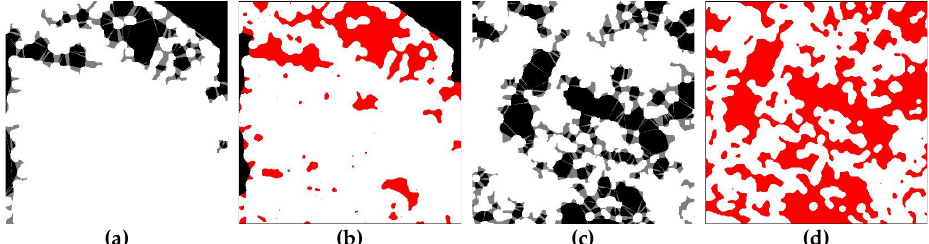
Figure 4. Delaunay triangulation OBIA. Dense urban area: ( a ) bridges between close regions, and ( b ) connected regions absorbed in the urban area displayed in the color red. Sparse urban area: ( c ) bridges between close regions, and ( d ) connected regions absorbed in the urban area displayed in the color